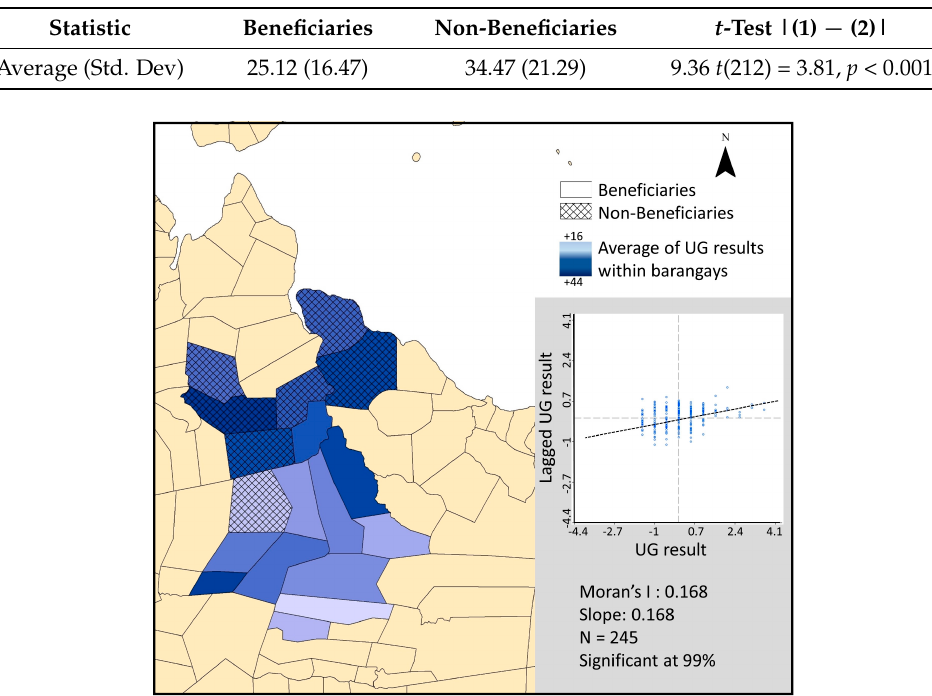
Table 3. Results for the Ultimatum Game (UG) experiment and the difference between beneficiaries and non-beneficiaries.